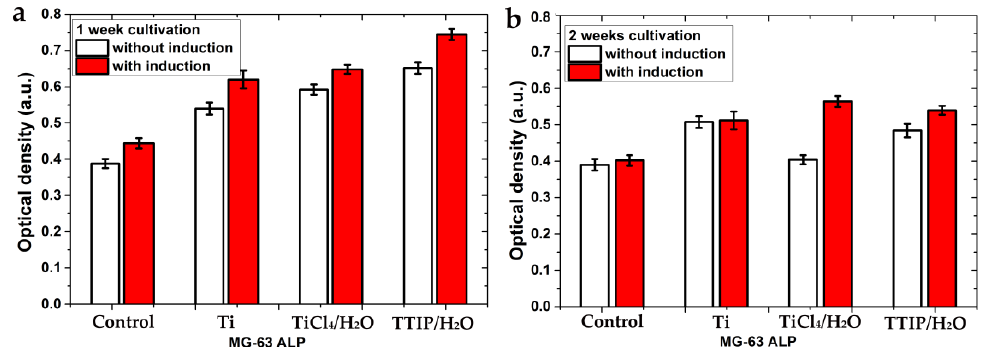
Figure 10. Alkaline phosphatase production by MG-63 cells on the samples with and without a medium-induced cellular differentiation in the osteogenic direction after 1 week of cultivation ( a ) and 2 weeks of cultivation ( b ). Each value represents mean ± S.D. from five independent experiments ( p = 0.05).